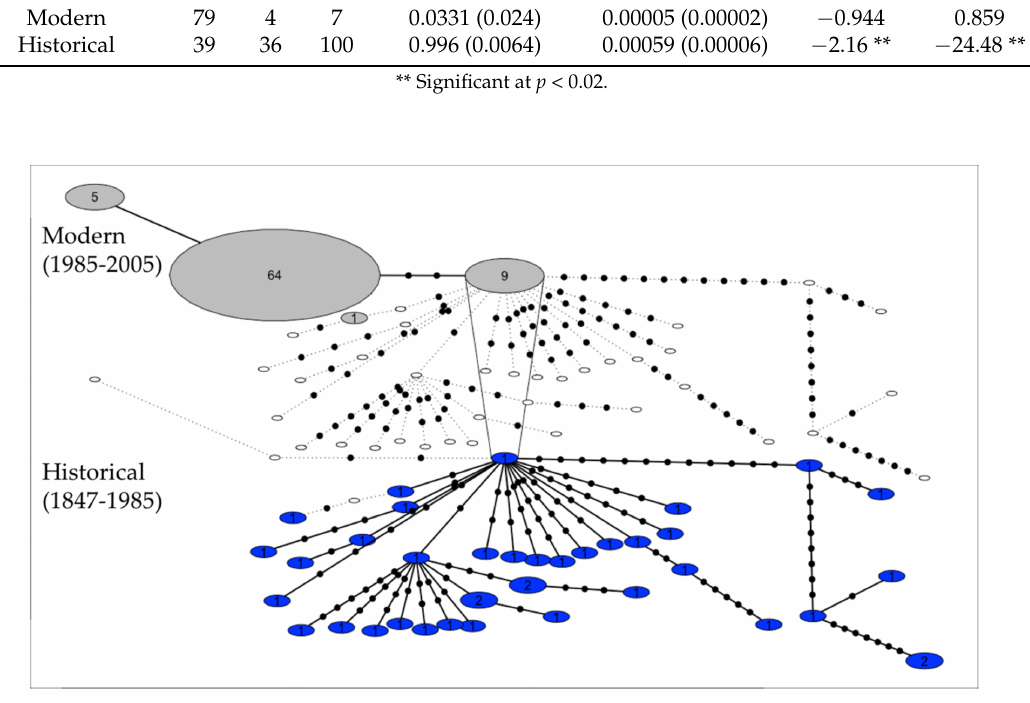
Figure 1. Temporal haplotype network displaying the change in mitogenome (16,588 bp) diversity through time for historical (in blue, bottom part; n = 39) and modern (in grey, top part; n = 79) k¯ak¯ap¯o samples. Circles represent haplotypes and numbers represent sample sizes. Empty circles represent absent haplotypes for a given time period. Haplotypes found in multiple time periods are connected by vertical lines. Within each time period, black dots represent one